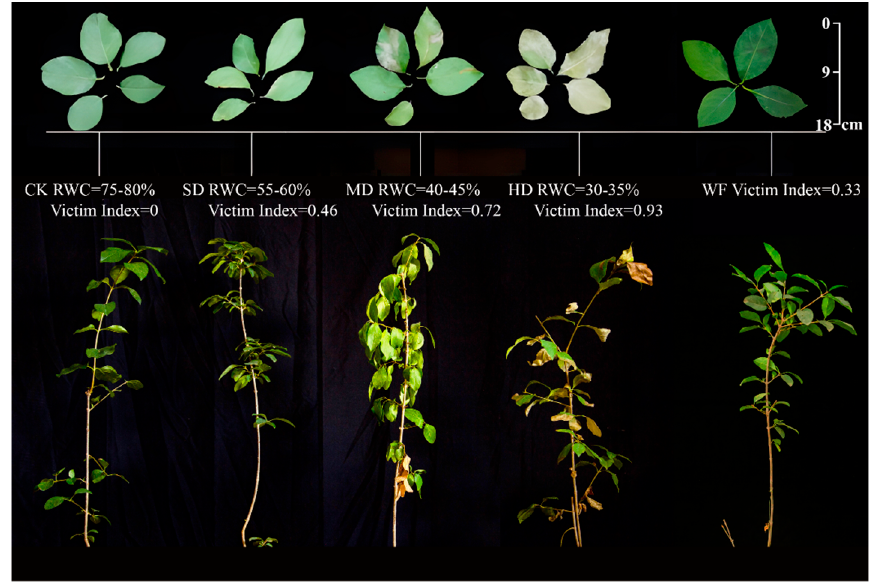
Figure 1. Effects of water stress on growth morphology of Chionanthus retusus clones (28 d). The top column shows the leaf state under different stress conditions, and the bottom column shows the plant growth state under different stress conditions. CK, control group; SD, slight drought treatment group; MD, moderate drought treatment group; HD, high drought treatment group; WF, flooded treatment group.